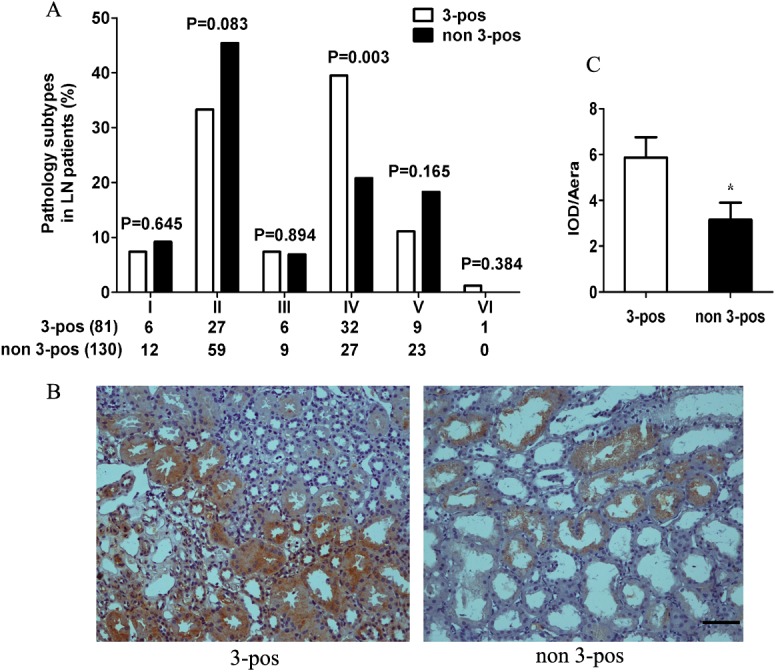
Correlation of 3-pos with LN subtype and kidney immune complex deposition in type IV LN.
(A) Correlations of 3-pos with LN subtype. (B) Deposition of immune complex in type IV LN in 3-pos or non-3-pos patients by immunohistochenistry. (C) Quantification of the postive staining in (B). IgG was labeled by HRP and represented for immune complex deposition. Four fields per biopsy sample were randomly counted and results were expressed as IOD/Area (Mean±SEM). Scale bar = 50 μm.